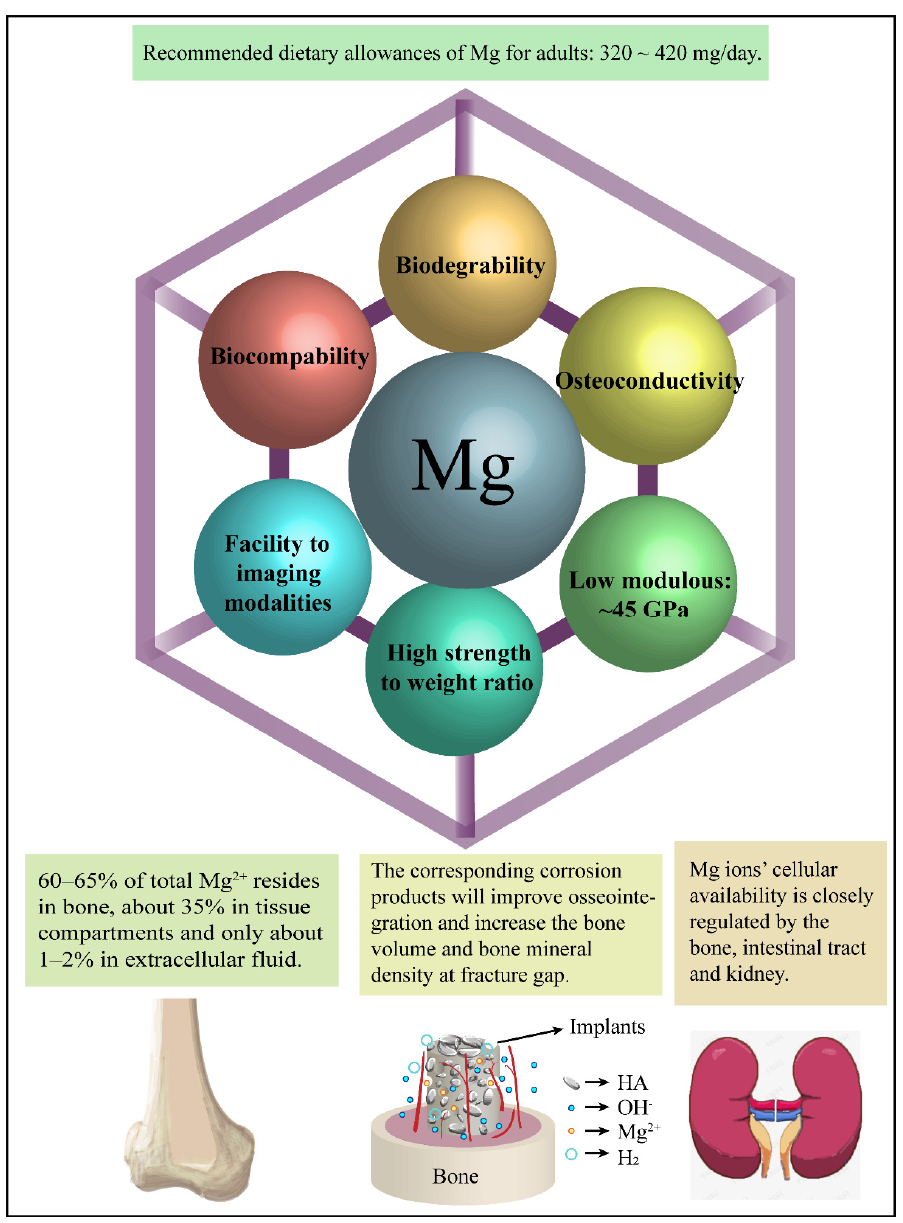
Figure 1. A summary of the advantages of biodegradable Mg-based implants. (1) The balance of magnesium ions can be precisely controlled by the kidney [14,24,42]. (2) Mg and its alloys exhibit an elastic modulus close to that of natural bone [43]. (3) Enhanced alkalinization is not only beneficial for the synthesis and crosslinking of collagen, but it also supports the formation of HA, which